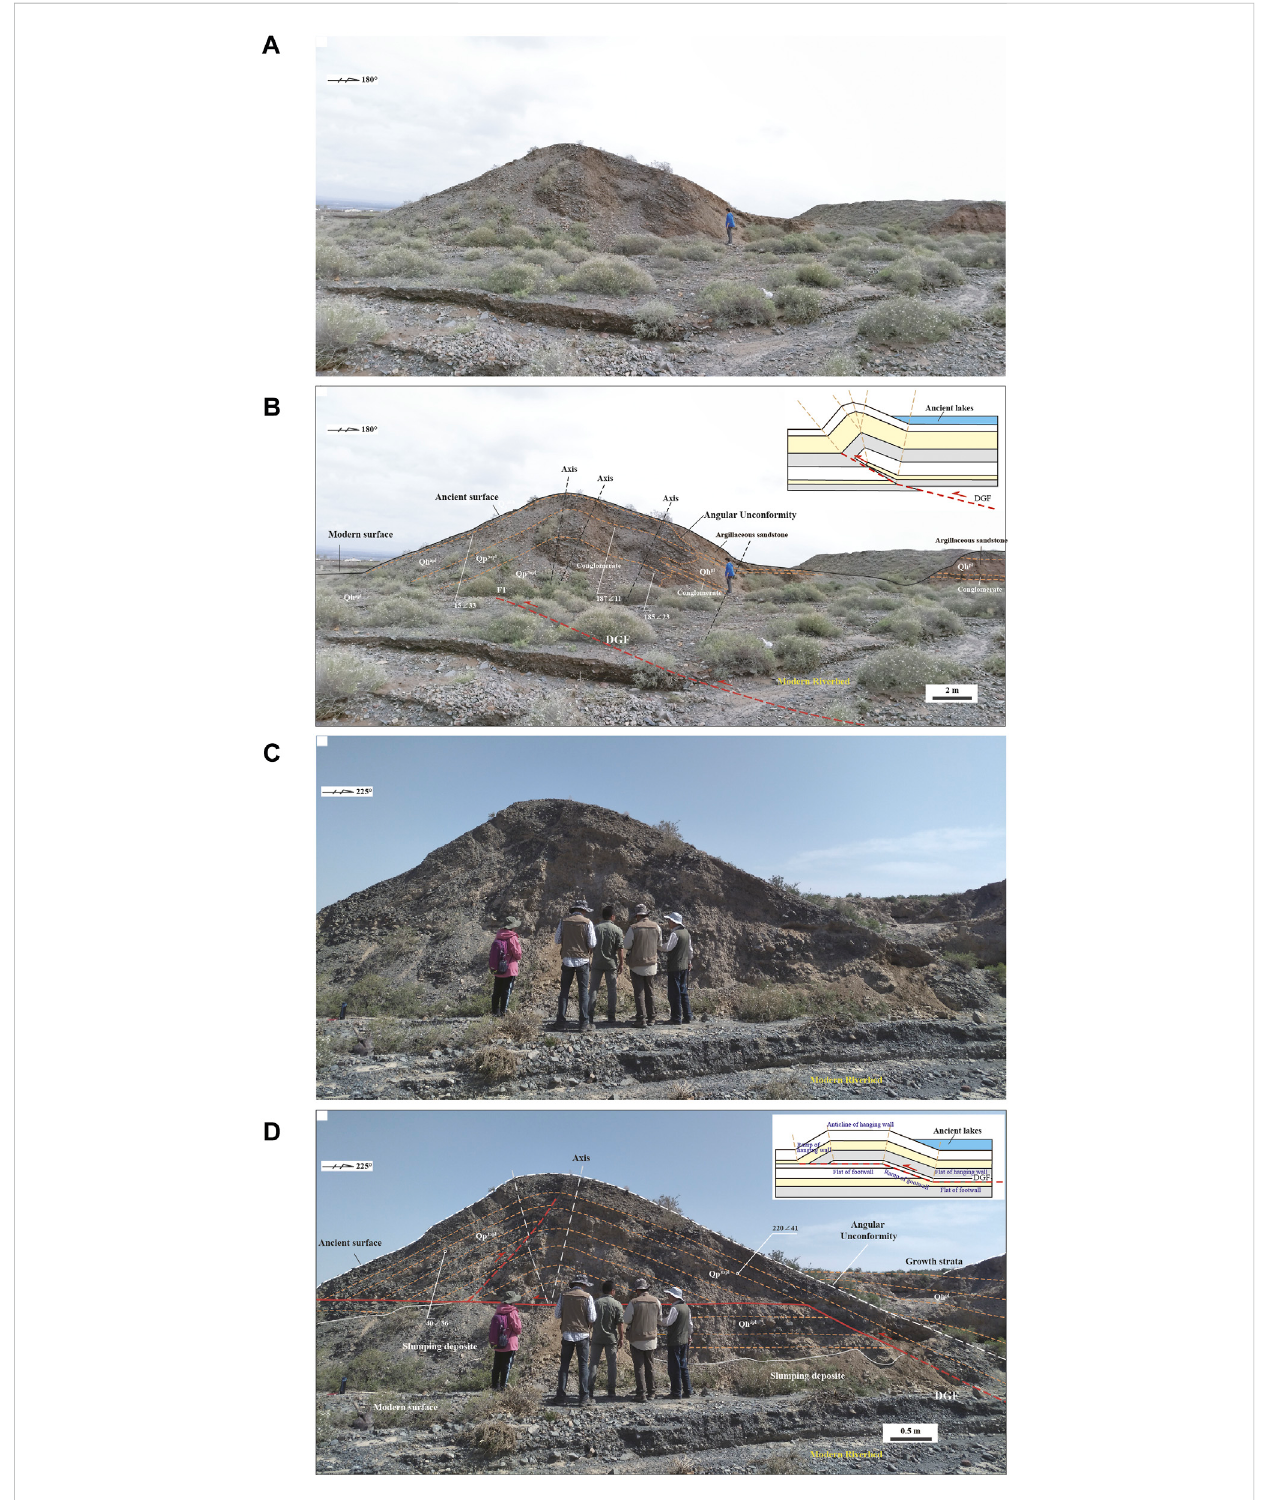
FIGURE 5 ross-sectionalview oftheDagengzianticlinebelt.The bulge-shapedbelts inthesurfaceindicatefault-propagation folding oftheHolocene surface (Qh)andblindthrustalongtheDagengziFault(DGF).Theupperrightcornershowsastructuralmodelforthefault-propagationfold (A,B) .Anothercross- sectional view of the Dagengzi anticlinebelt. The bulge indicates fault-bend folding of the Holocene surface (Q 4 )and thrusting ramp and fl at of theDGF. The upper right corner shows a model for the fault-bend fold (C,D) . Bedding is expressed as the dipping direction and dip